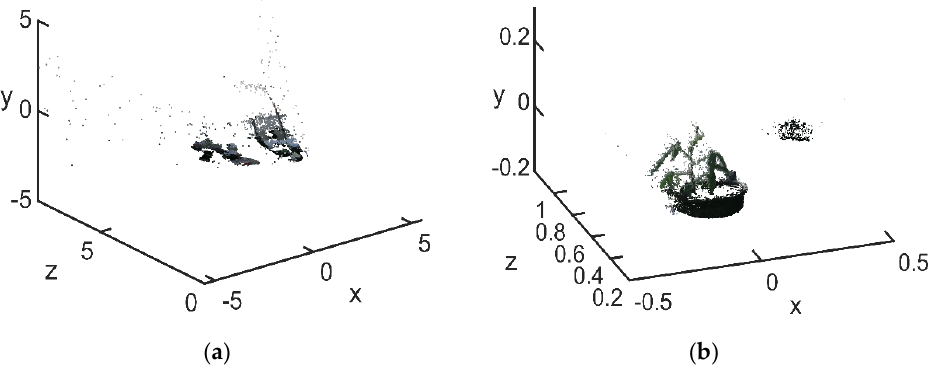
Figure 4. Comparison before and after point cloud conditional filtering: ( a ) before conditional filtering; ( b ) after conditional filtering.